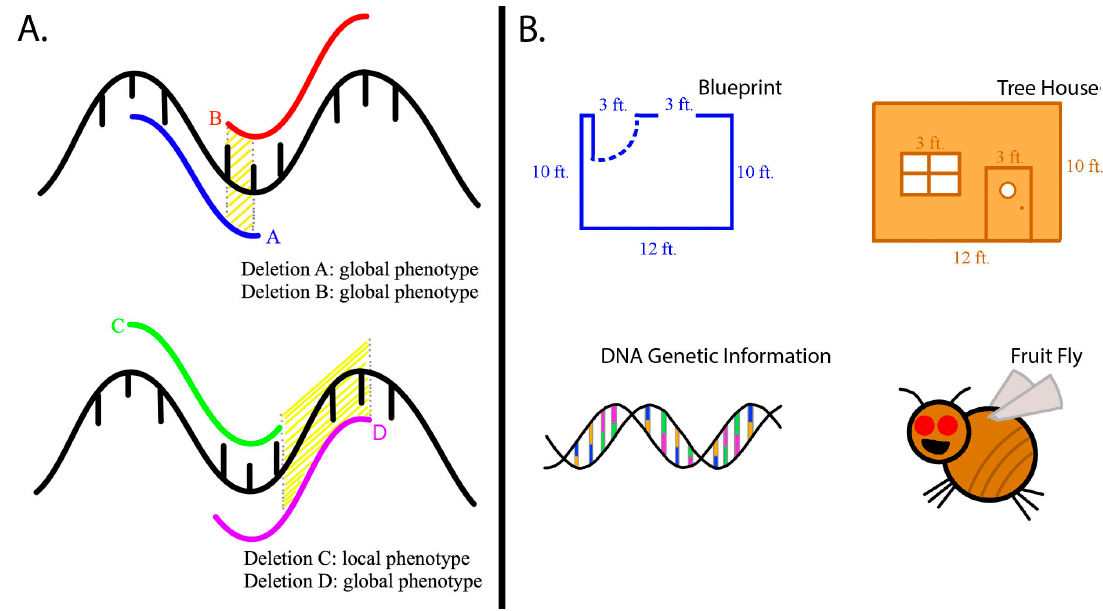
Figure 1. Main focus of the Frontiers for Young Minds article. ( A ) Initial illustration. ( B ) Revised illustration.